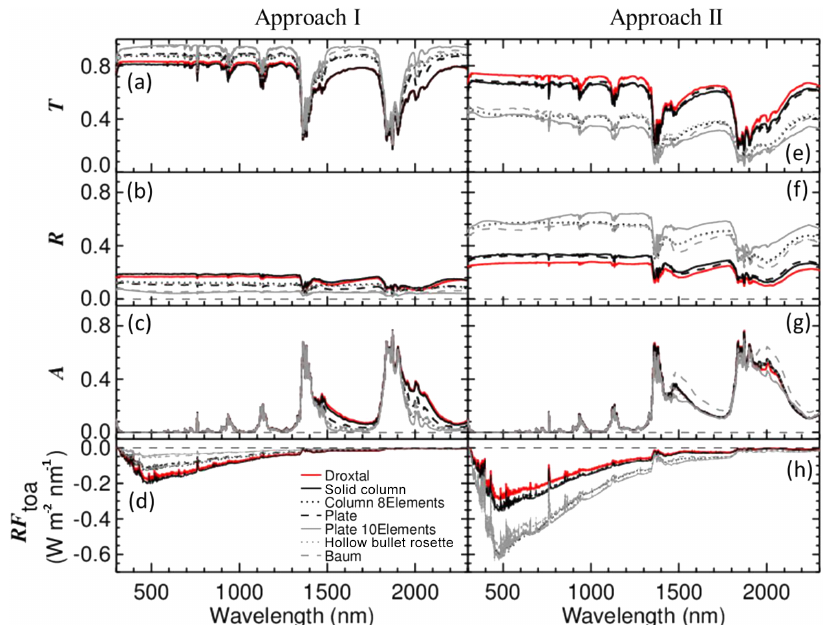
Figure 11. Spectral (a, e) transmissivity, (b, f) reflectivity, and (c, g) absorptivity of a cirrus layer between 6.7 and 8.5km altitude. (e, h) are the radiative forcings at TOA, respectively. The simulations are based on a measured number size distribution assuming different ice particle shapes. The two panels indicate two conditions: constant number size distribution (approach I) and constant ice water content (approach II).